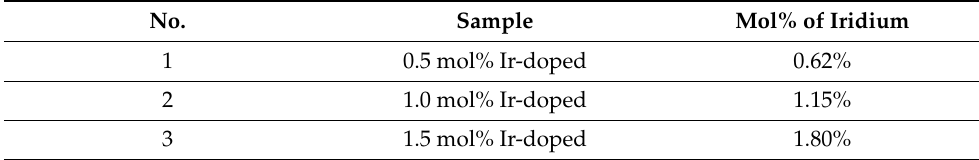
Figure 4. TEM images of Ir-doped TiO 2 photocatalysts with different iridium concentrations. ( a ) 0.5 mol% Ir-doped sample; ( b ) 1.0 mol% Ir-doped sample; ( c ) 1.5 mol% Ir-doped sample. Table 1. Percentage of iridium in different samples obtained from EDX analysis. No.